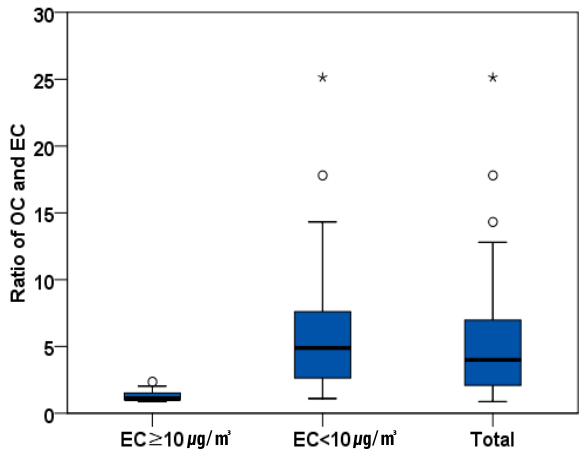
㎍ / ㎥ ㎍ / ㎥ Figure 2. Ratio of organic carbon (OC) and elemental carbon (EC) by EC exposure level. The box represents the interquartile (IQ) range which contains the middle 50% of the records and whiskers indicate 10th and 90th percentiles. Outliers (circles, ◦ ) are cases with values between 1.5 and 3 times the IQ range. Extremes (asterisks, *) are cases with values more than 3 times the IQ range.